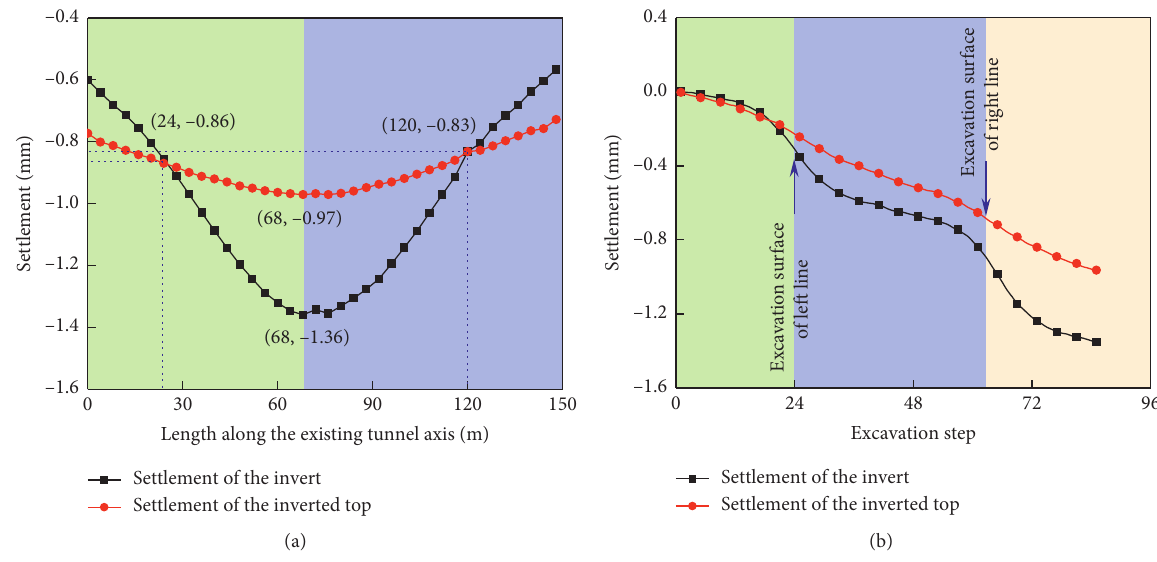
Figure 7: Settlement characteristics of invert and inverted top of the existing tunnel. (a) Relationship between settlement value and axial distance of invert and inverted top. (b) Relationship between settlement value and excavation step of invert and inverted